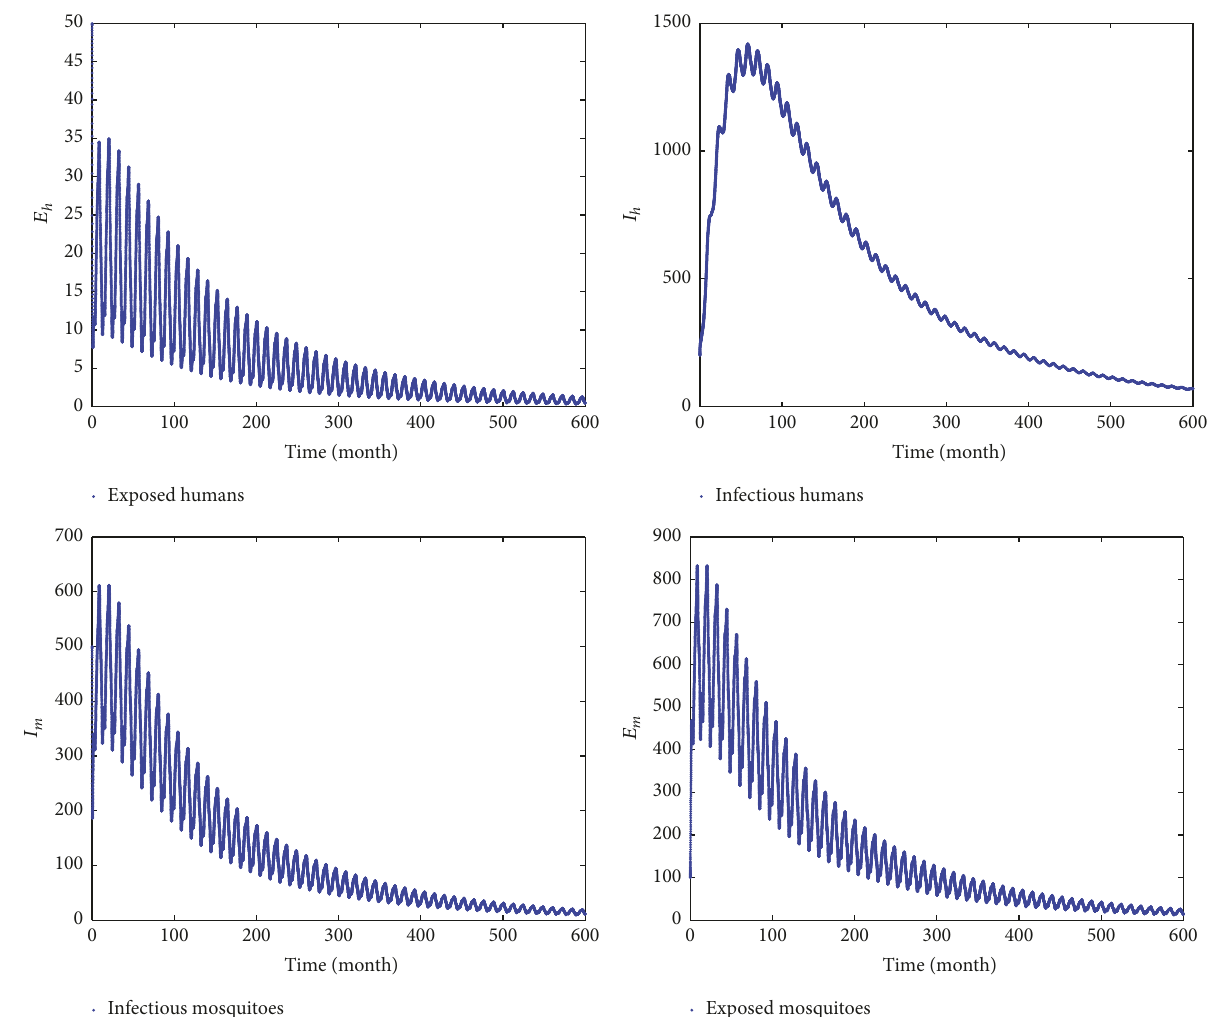
Figure 7: Distribution of infected humans and mosquitoes for 𝑏 = 80 , 𝑠 = 10 , 𝑑 = 15 , 𝑠 𝐿 = 6 , and 𝑑 𝐿 = 14